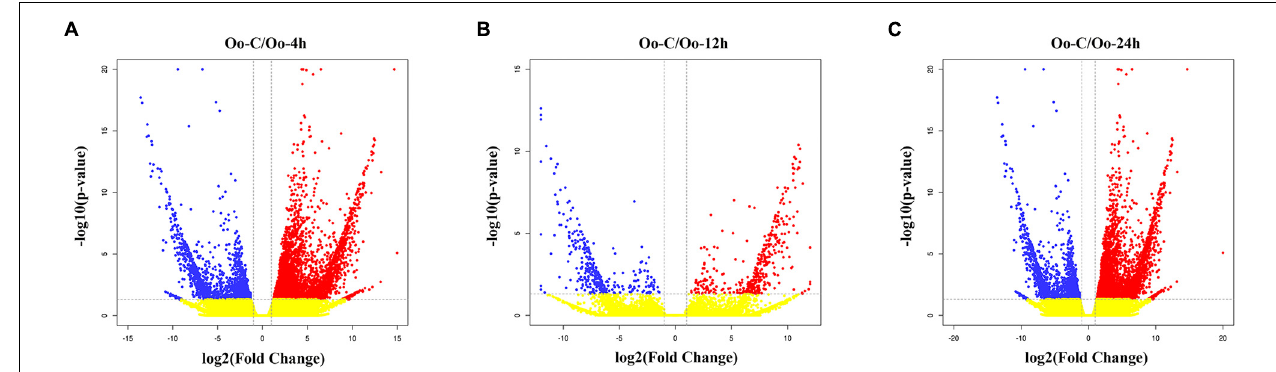
FIGURE 1 | (A) Volcano plot of DEGs distribution trends between Oo-C and Oo-4h. Each dot stands for a gene. Red dots indicate up-regulated DEGs; blue dots are down-regulated DEGs; and yellow dots stand for the genes with no difference. (B) Volcano plot of DEGs distribution trends between Oo-C and Oo-12h. (C) Volcano plot of DEGs distribution trends between Oo-C and Oo-24h.